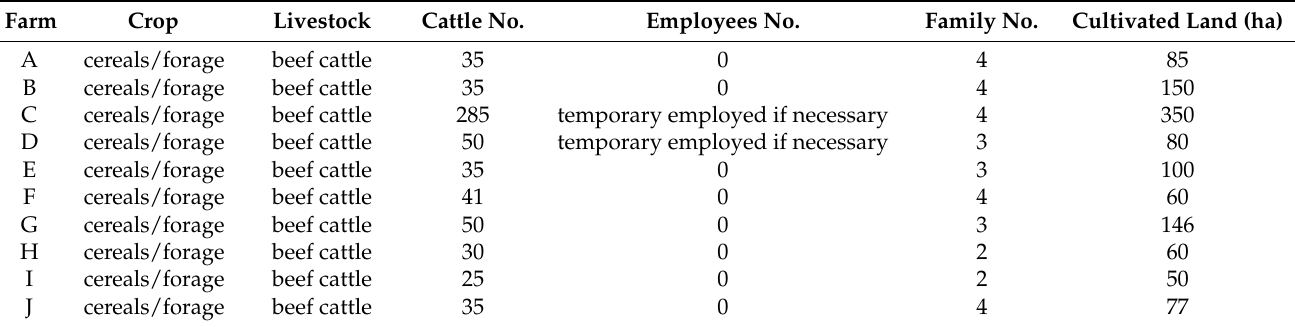
Table 2. Characteristics of the analyzed farms